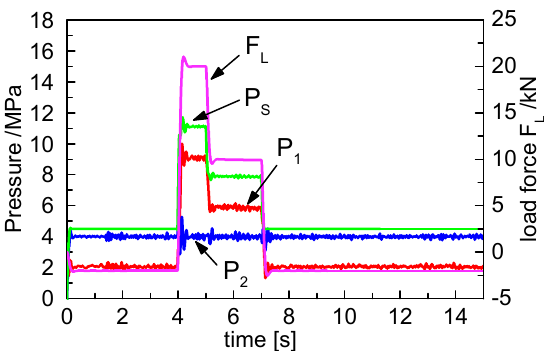
F of the electro-hydraulic servo system (EHSS).